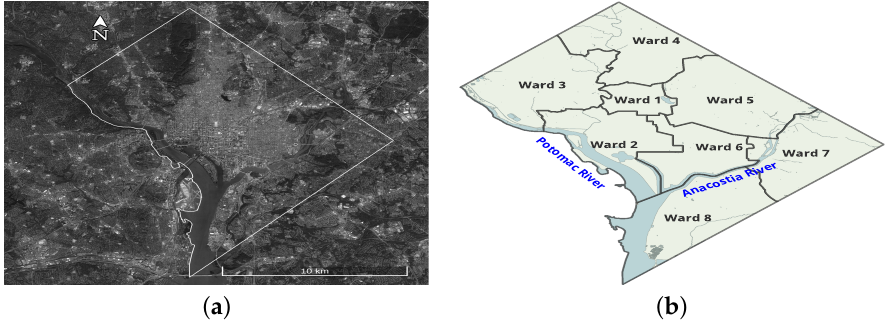
Figure 3. ( a ) Orthoimage of Washington D.C. ( b ) Division of Washington D.C. by wards. River names are represented in